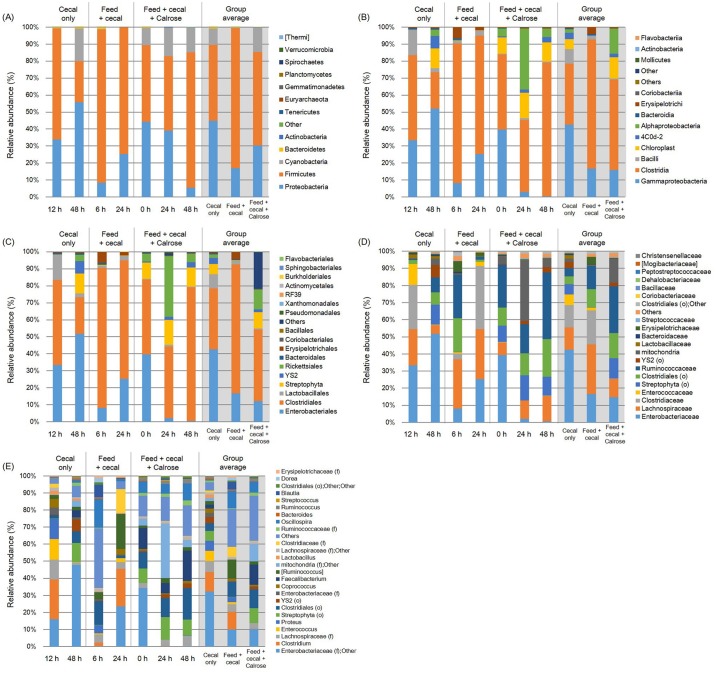
Relative abundance of major bacteria among different treatment groups at (A) phylum, (B) class, (C) order, (D) family, and (E) genus level in anaerobic mixed cultures (adapted condition) containing cecal contents.Microbiome analysis was conducted in triplicate on cecal contents only, feed and cecal contents, and feed + cecal + Calrose at various time points using cecal contents from 28 day-old broiler chickens. The bars represent the standard deviation. “f” and “o” in parentheses indicate family and order, respectively.